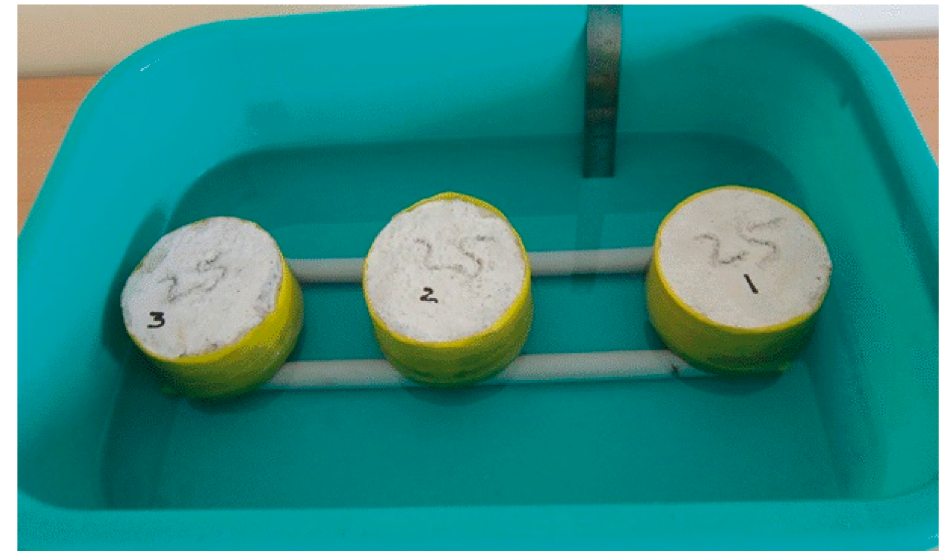
Figure 7: Sorptivity test.